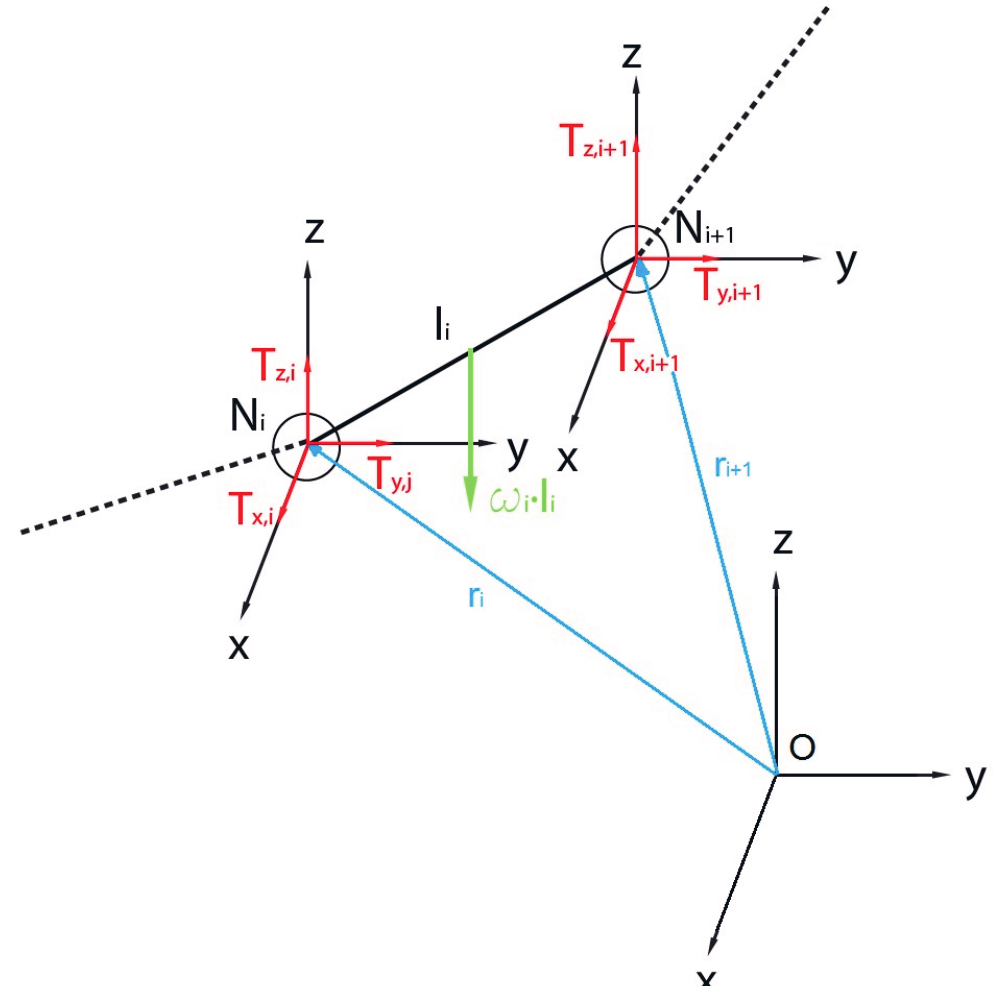
Figure 7. Force scheme of two consecutive